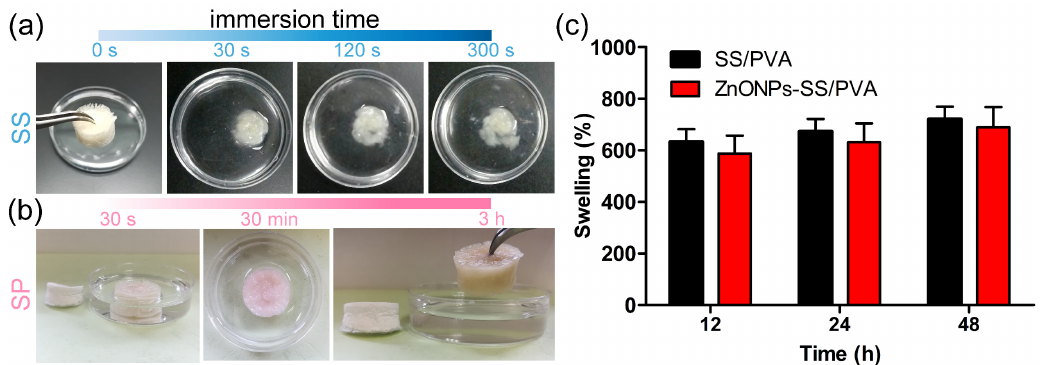
Figure 5. Porosity and swelling ratio. ( a ) The performance of sericin sponge in water, ( b ) The swelling of ZnONPs-SP sponge, ( c ) The swelling ratio of SP and ZnONPs-SP